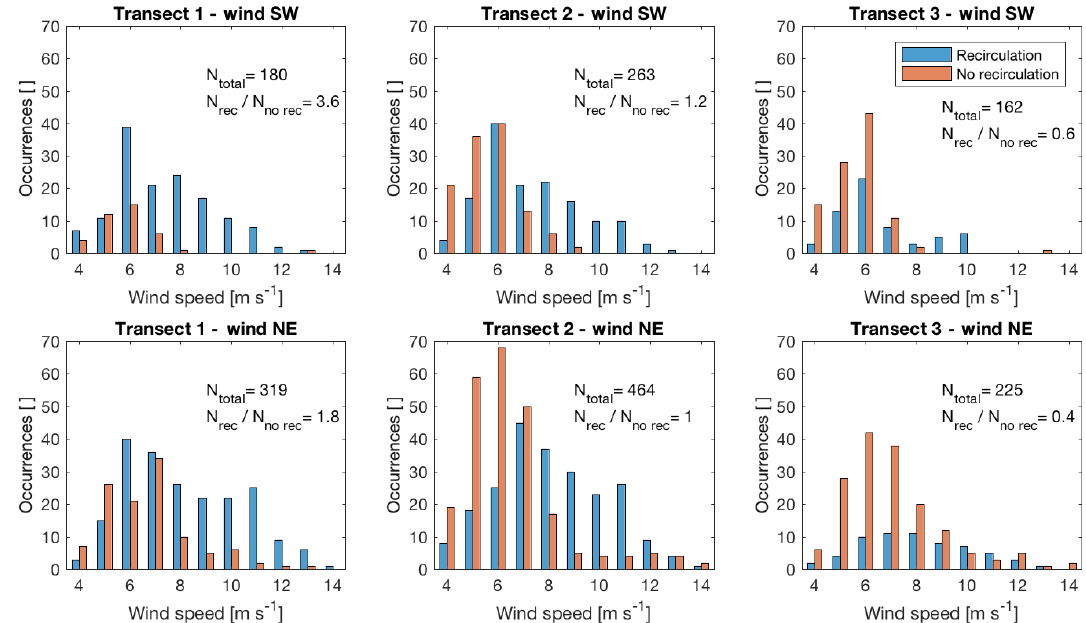
Figure 7. Occurrence of recirculation depending on the mean wind speed measured by the 100m sonic on the upstream mast. The histograms are separated by transect and wind direction.